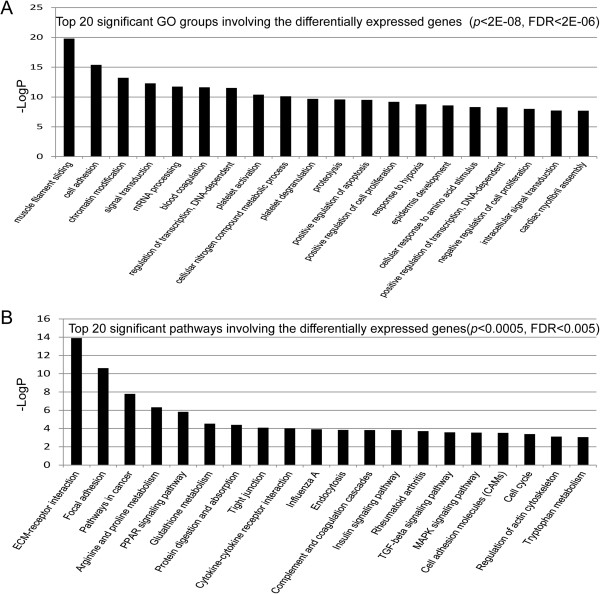
Gene ontology and pathway analysis of differential genes. (A) Top 20 significant GO groups involving the differentially expressed genes (p < 2E-08, FDR < 2E-06). (B) Top 20 significant pathways involving the differentially expressed genes (p < 0.0005, FDR < 0.005). The greater –Logp, the higher the significance.